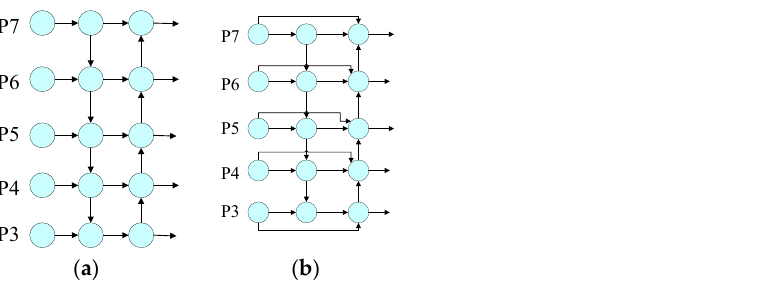
Figure 9. Method diagram for YOLOv5m-DSM.